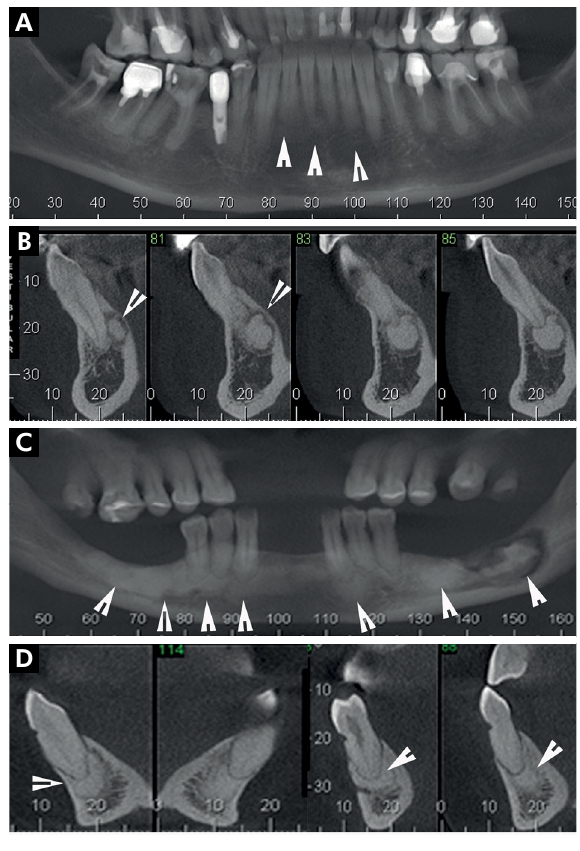
Figure 2. Periapical cemento-osseous dysplasia (periapical COD): Panoramic images showing hyperdense round lesions in the periapical region of a mandibular anterior sound tooth (arrowhead) (A). Cross-sectional images showing periapical COD lesions markedly separated from the adjacent normal bone and also separated from the root of the anterior tooth (arrowhead) (B). Florid COD: In CBCT images, hyperdense multiple lesions are observed that involve the mandible bilaterally (arrow head) and bone sequestration in left mandible (arrow) (C). In (D), hyperdense elliptical lesions are seen clearly separated from the root of a mandibular tooth